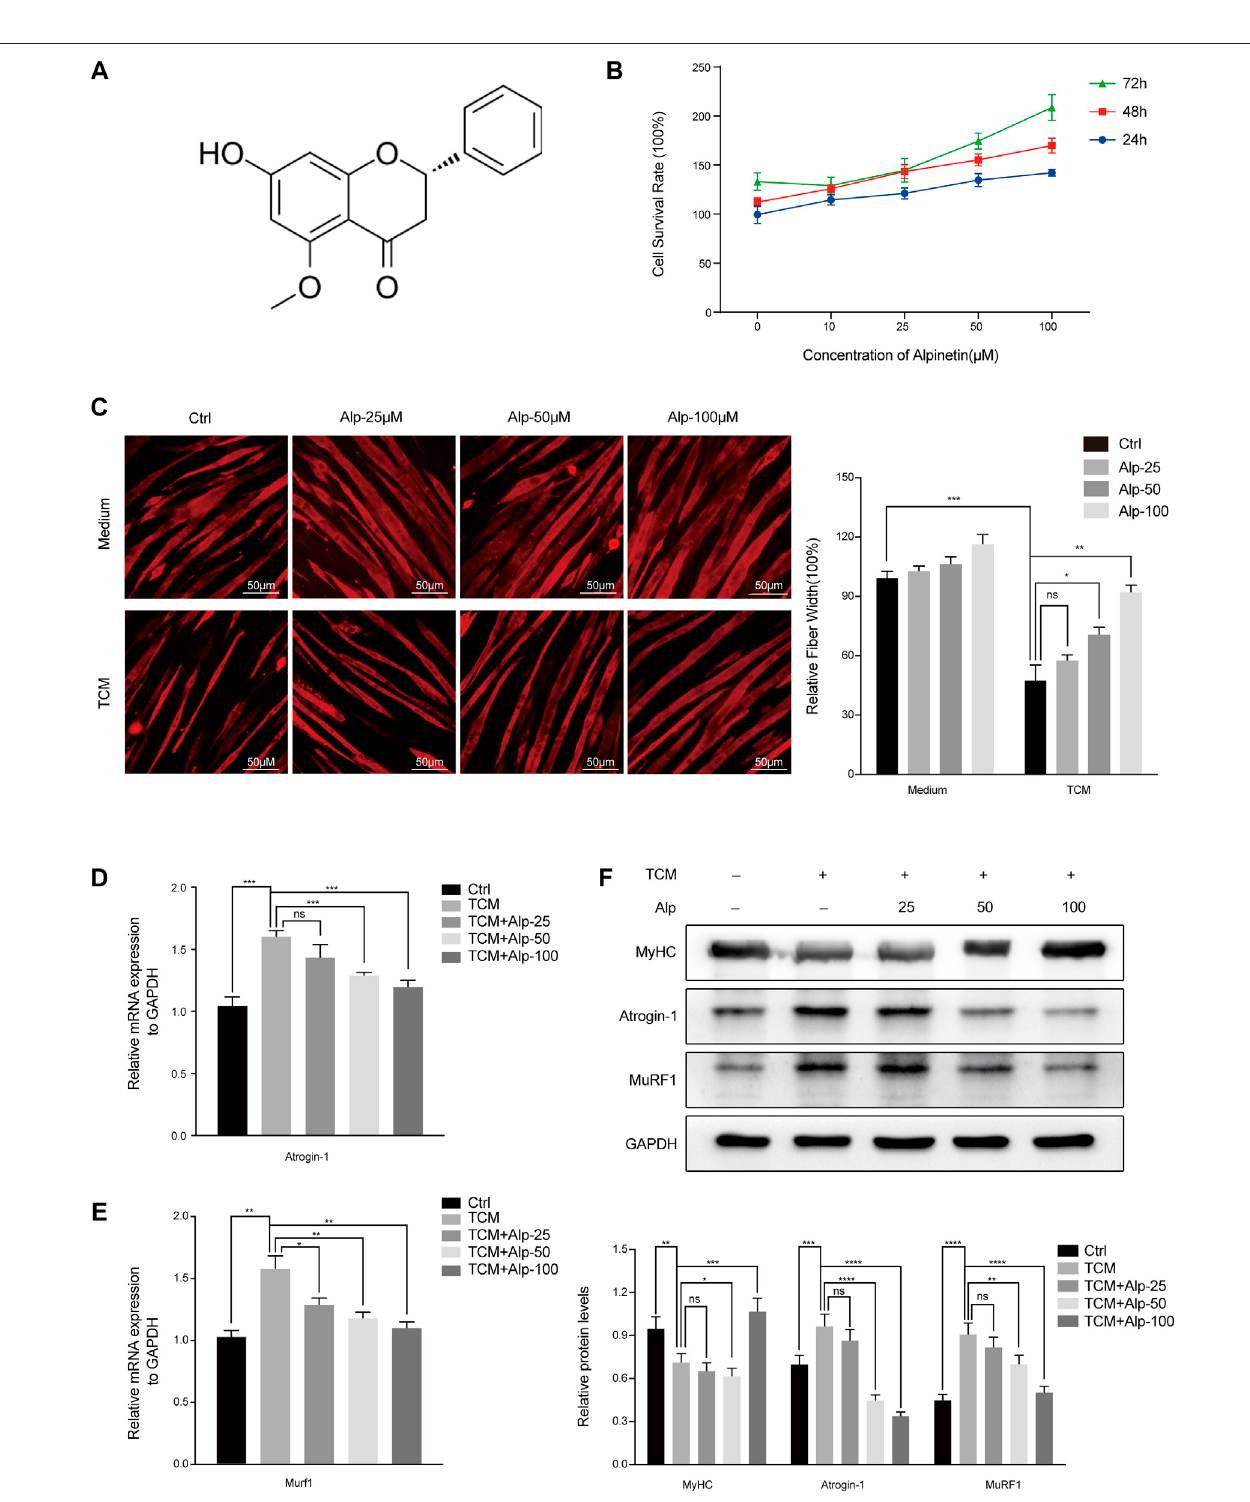
FIGURE 1 | Alp reduces TCM-induced myotube atrophy. (A) The chemical structure of Alp. (B) The effect of Alp on C2C12 myotube viability. Myotubes were cultured with increasing concentrations of Alp (0, 10, 25, 50, and 100 μ M) for 24, 48, and 72 h in the presence of Alp, and their viability was detected by CCK-8 assay. C2C12 myotubes were treated with Alp at various concentrations and stimulated by LLC TCM for 48 h. (C) Representative images of immuno fl uorescence staining for MyHC (red) are presented (left) . The relative fi ber widths of each experiment were quanti fi ed (right) . mRNA levels of Atrogin-1 (D) and Murf1 (E) were analyzed by real-time PCR and normalized to GAPDH. (F) Western blot was used to detect the expression levels of indicated proteins, and the band densities were quanti fi ed and normalized with GAPDH. * p < 0.05, ** p < 0.01, *** p < 0.001, **** p < 0.0001 vs. control. ns: not signi fi cant. n (cid:1) 3.